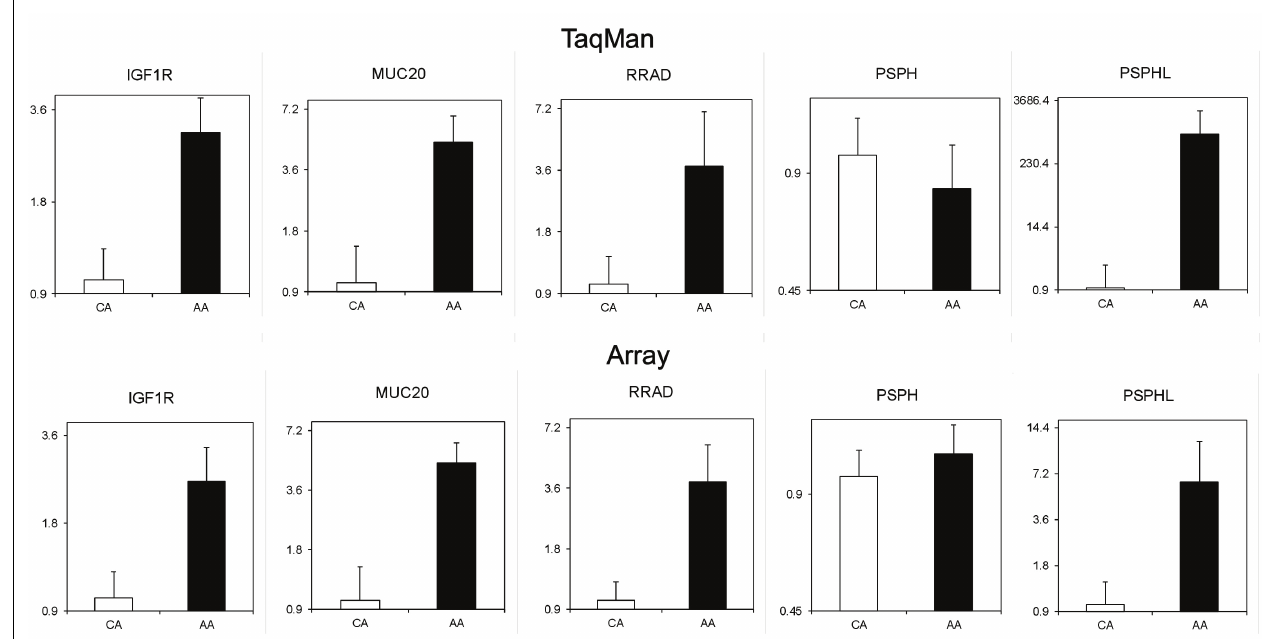
row. The expressions were normalized to endogenous β -actin and then the ratios to Caucasian are shown. Bottom row is from array data of same samples.